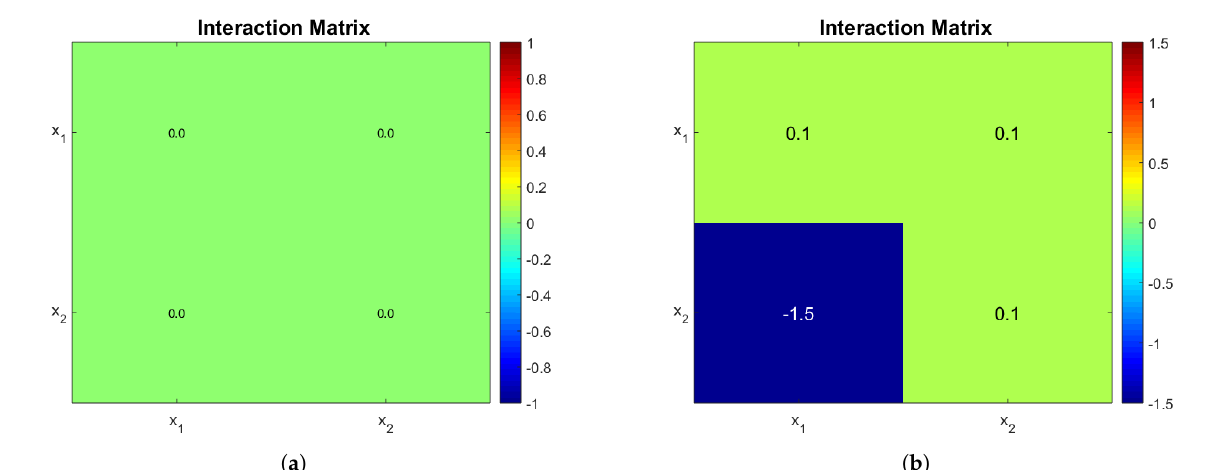
Figure 1. Interaction matrices. Note how the presence of x 1 affects very negatively x 2 in ( b ), with respect to other interactions. The terms in the diagonal entries of the matrix represent intraspecies interactions, while the terms off the diagonal represent the interspecies interactions. ( a ) Interaction matrix of model (3) with no interactions. ( b ) A non-zero interaction matrix of model